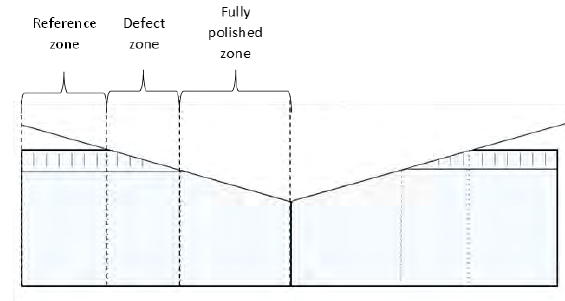
Fig . 2 . V-shape polished surface with marked referenc (ground), defected, and fully polished zone.